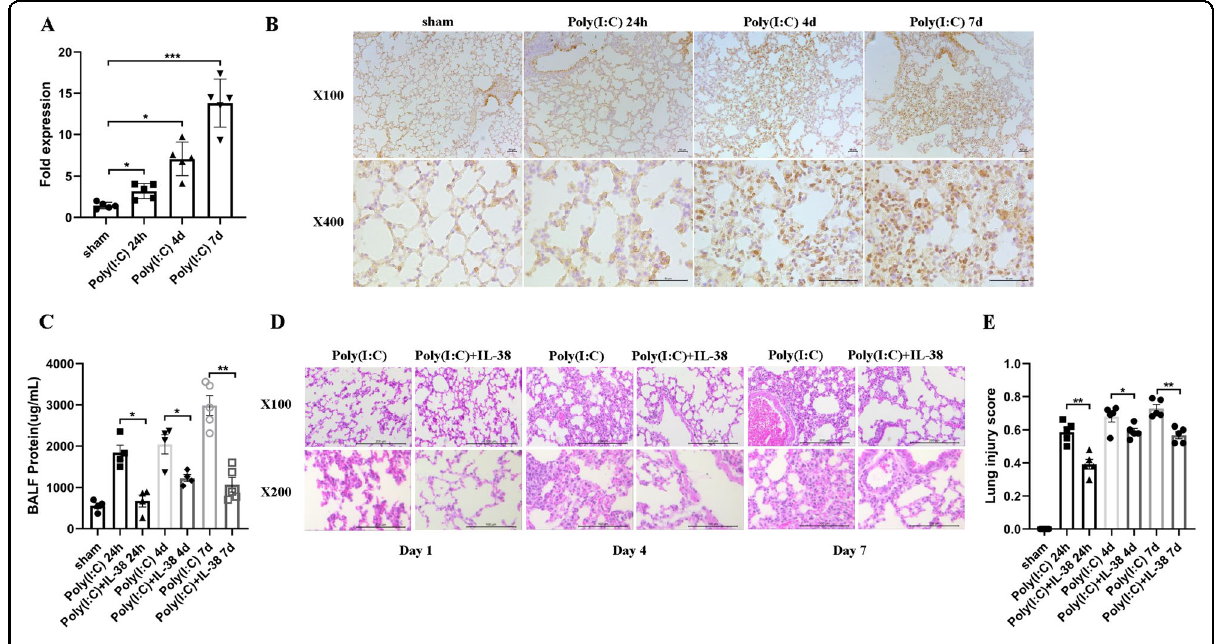
Fig. 3 IL-38 expression in the lung is upregulated upon poly(I:C) exposure in vivo and ameliorates poly(I:C)-induced acute lung injury. C57BL/6 mice ( n = 5) were injected intranasally with poly(I:C) (10 mg/kg/mouse) with/without recombinant murine (rm) IL-38 (800 ng/injection) per day. ( a ) IL-38 mRNA levels in the lung were measured by quantitative real-time PCR (QT-PCR). ( b ) IL-38 protein levels in the lung were detected by immunohistochemistry. ( c ) Total protein concentrations in the BALF were measured with BCA protein assay kit. ( d ) Representative result of hematoxylin and eosin (H&E)-stained lung from mice ( n = 5 per group) treated with or without rmIL-38 at 24 h, 4 days and 7 days after poly(I:C) injection. ( e ) Histological scores for lung injury assessment in the mice treated with or without rmIL-38 at 24 h, 4 days, and 7 days after poly(I:C) injection. Data are shown as the mean ± SEM of three duplicate tests. Nonparametric Kruskal-Wallis test followed by Dunn ’ s multiple comparisons test and/or Mann-Whitney test was used to compare the differences between groups. * P < 0.05, ** P < 0.01, and *** P <